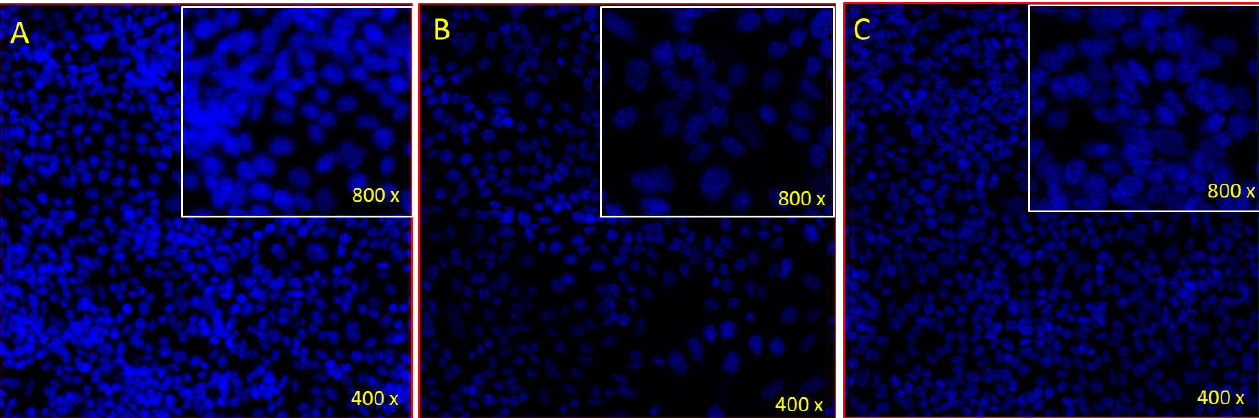
Figure 18. Cancer cells morphology by DAPI staining. ( A ) Control; ( B ) and ( C ) treated with 40 µg/mL of chrysophanol and emodin, respectively.